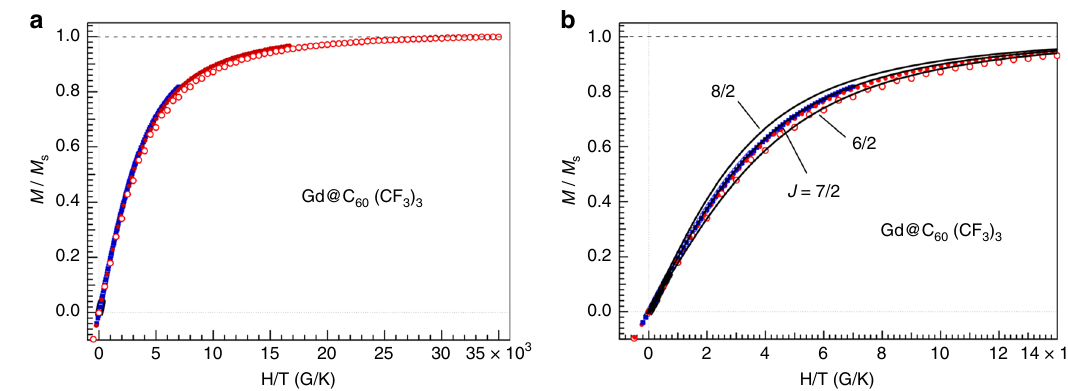
Fig. 3 Normalized magnetization curves of Gd@C 60 (CF 3 ) 3 . a Whole trace of magnetization taken at 273, 100, 20, 10, 4.2, and 2 K, and b is an expansion around the origin of abscissa. M s value determined experimentally is 41108 emu · G mol − 1 . Solid lines are the calculated magnetization curves using Brillouin function with J = 8/2, 7/2, and 6/2. Red open circles are for the data taken at 2 K. Only this data set did not fi t with the same